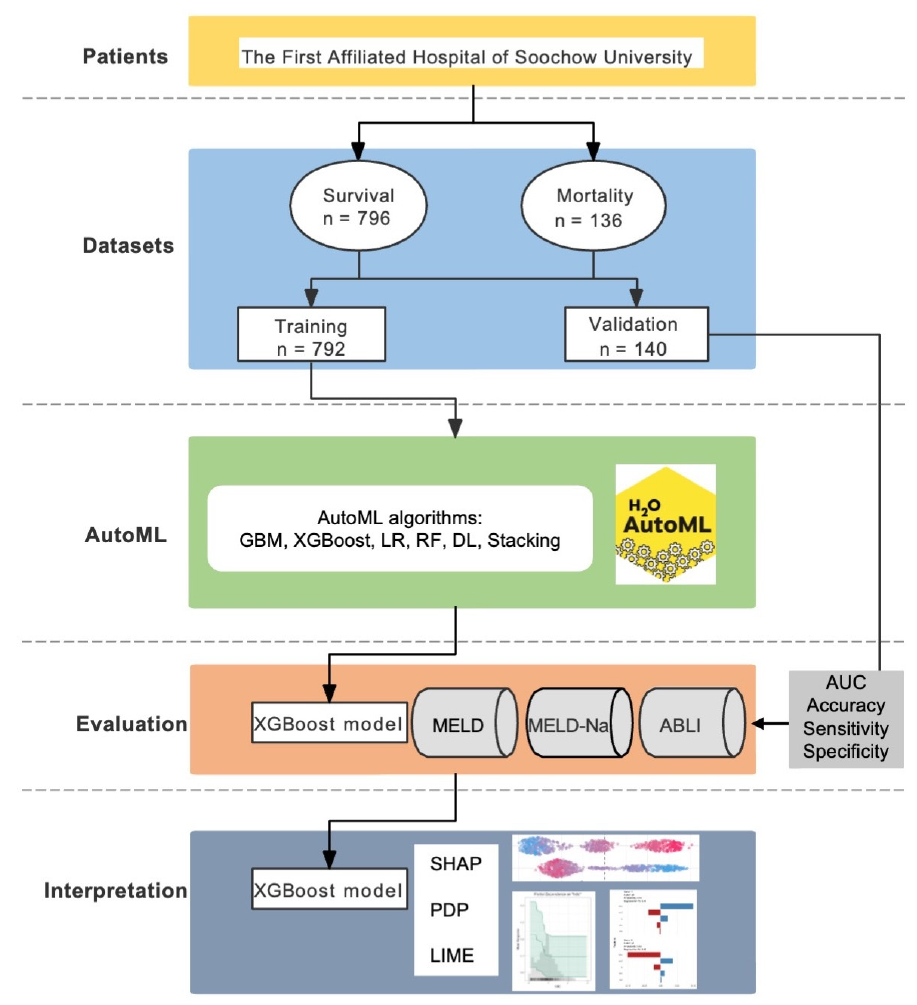
Figure 1. Flowchart of the study.